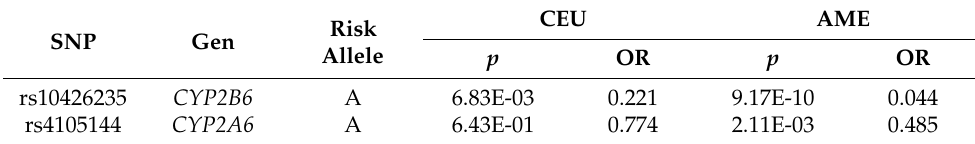
Table 3. Results of the allele association in CTS vs. SWOC according to the ancestral